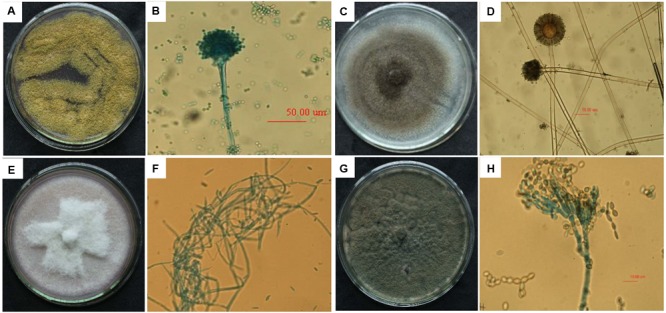
The colony characteristics and microscopic morphology of Aspergillus flavus (A: colony on medium; B: conidium terrier and top sac), A. niger (C: colony on medium; D: conidium terrier and top sac), Fusarium moniliforme (E: colony on medium; F: mycelium), and Penicillium (G: colony on medium; H: conidium).